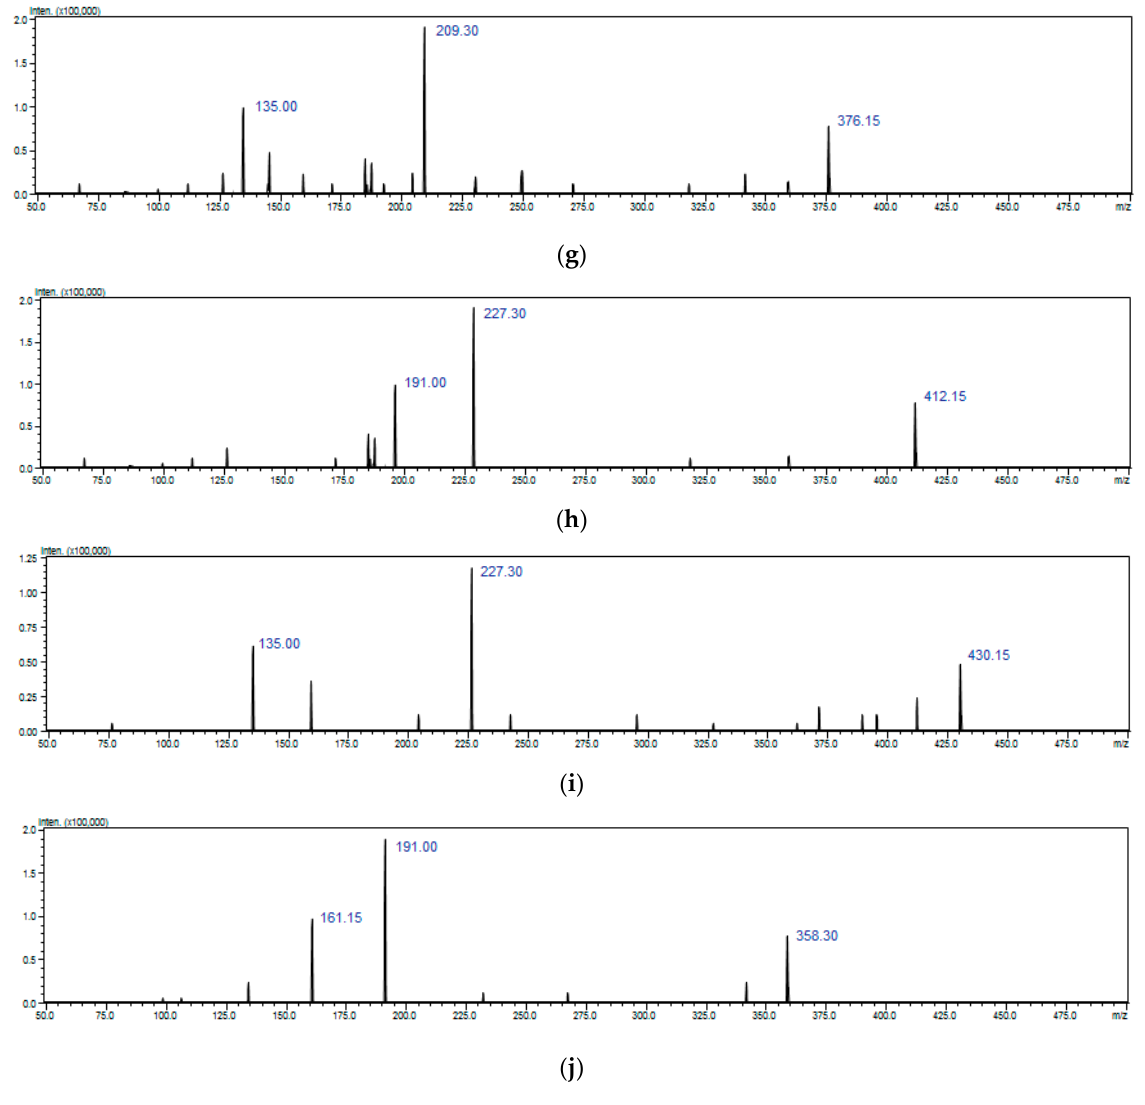
Figure 2. QqQ-ESI-MS/MS spectra of (a) BPS ( m/z = 249 ), (b) BPF ( m/z = 199 ), (c) BPE ( m/z = 213 ), (d) BPA ( m/z = 227 ), (e) BPAF ( m/z = 335 ), (f) BADGE•2H 2 O ( m/z = 394 ), (g) BADGE•H 2 O ( m/z = 376 ), (h) BADGE•H 2 O•HCl ( m/z = 412 ), (i) BADGE•2HCl ( m/z = 430 ), (j) BADGE ( m/z = 358 ).